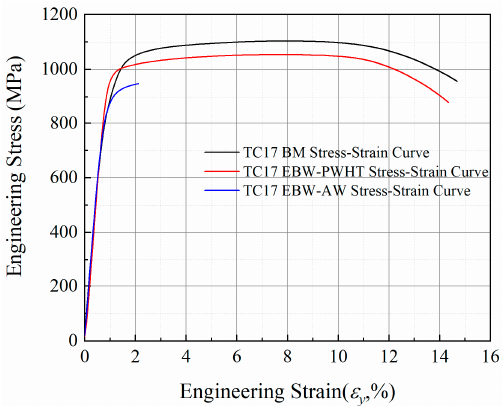
Figure 5. Stress ‐ strain curves of the base metal, as ‐ welded TC17 EBW joint, and PWHT of TC17 EBW joint. Table 2. Tensile test data of TC17 EBW joints at room temperature.